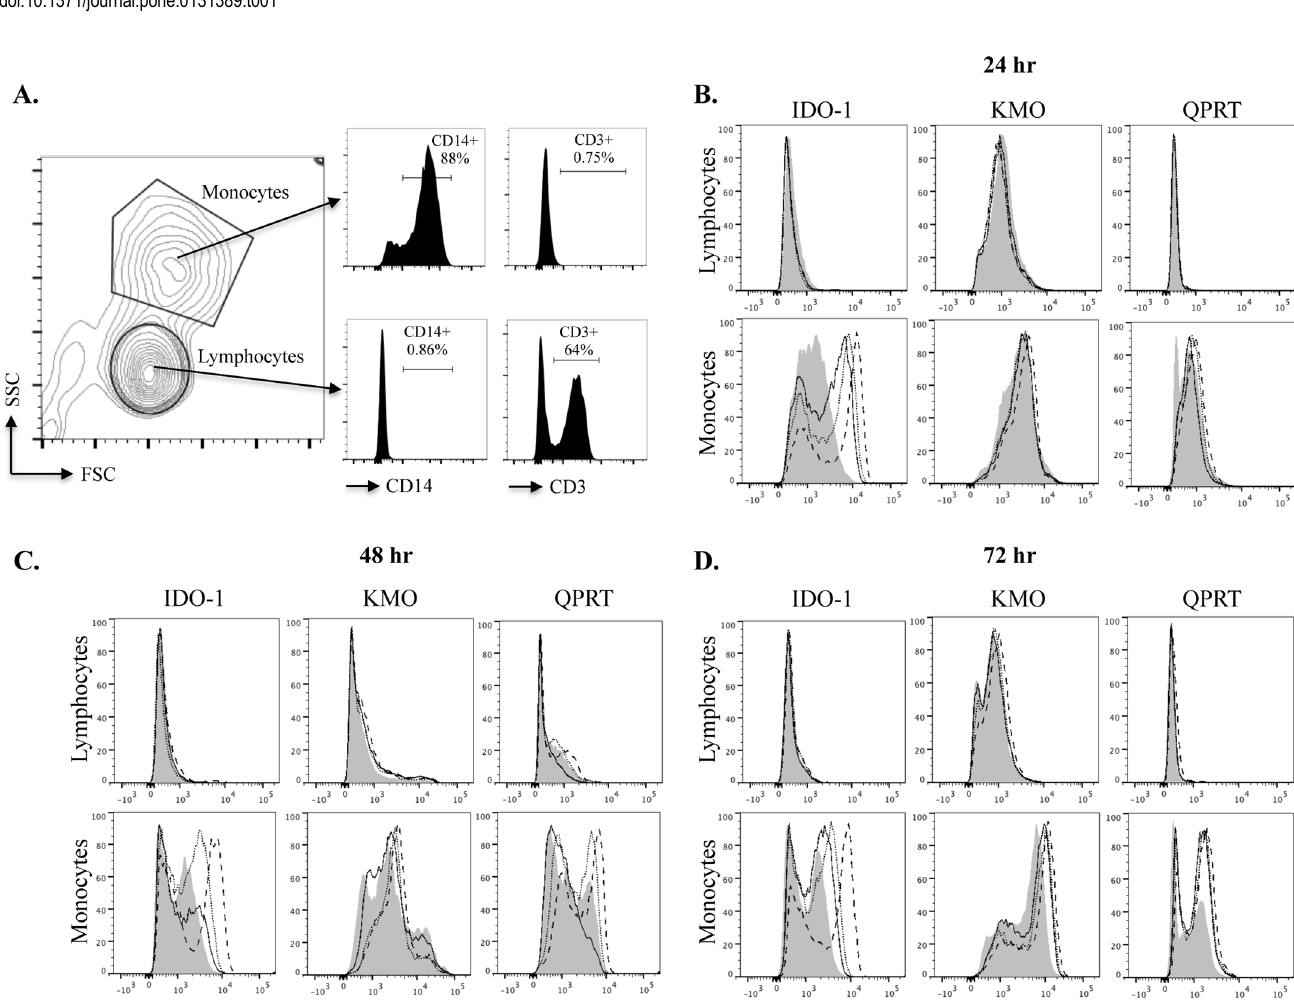
Fig 2. Expression of IDO-1, KMO and QPRT in lymphocytes and monocytes treated with IFN- γ . Flow cytometry histogram plots are based on forward scatter (FSC) and side scatter (SSC) gating for lymphocyte and monocyte populations. This was validated using CD14 and CD3 staining in some experiments. A representative example of the gating strategy is shown in ( A ). For histogram plots the mean fluorescence intensity (MFI) of expression for IDO-1, KMO and QPRT is represented on the x axis and normalized event numbers on the y axis at 24 hours ( B ), 48 hours ( C ) and 72 hours ( D ) of IFN- γ treatment. Untreated (control) cells are shown as the filled distribution, 50 IU/mL IFN- γ solid lines, 100 IU/mL IFN- γ dotted lines and 500 IU/mL IFN- γ dashed lines. Data is representative of at least 5 independent